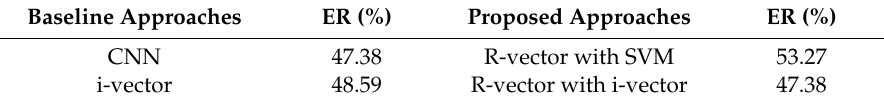
Table 7. Performance (Error Rate (ER)) of three-class LID experiments on Mozilla corpus. Baseline